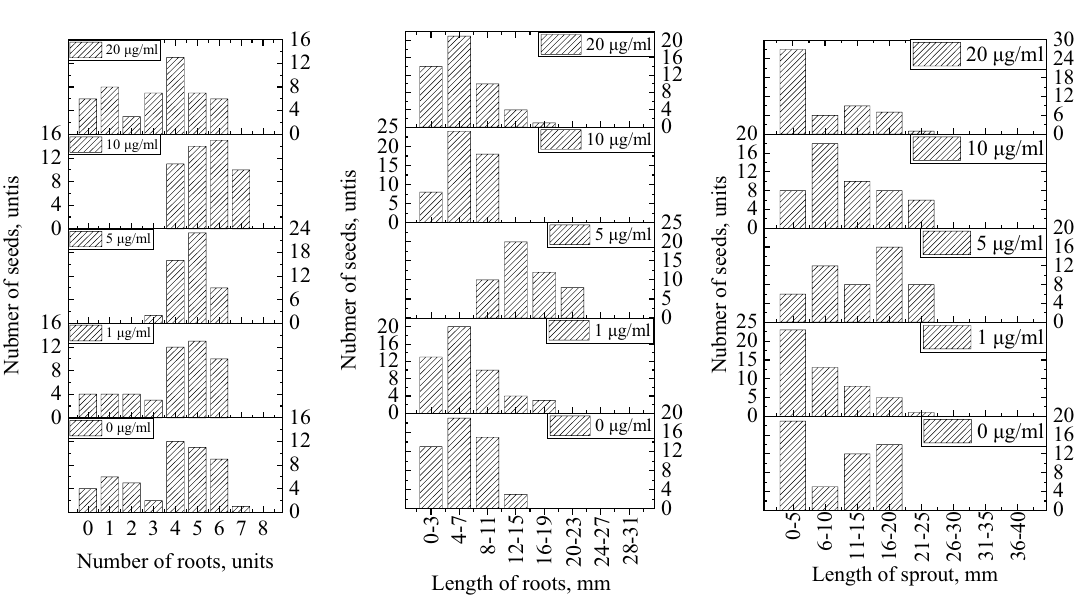
0 1 2 3 4 5 6 7 8